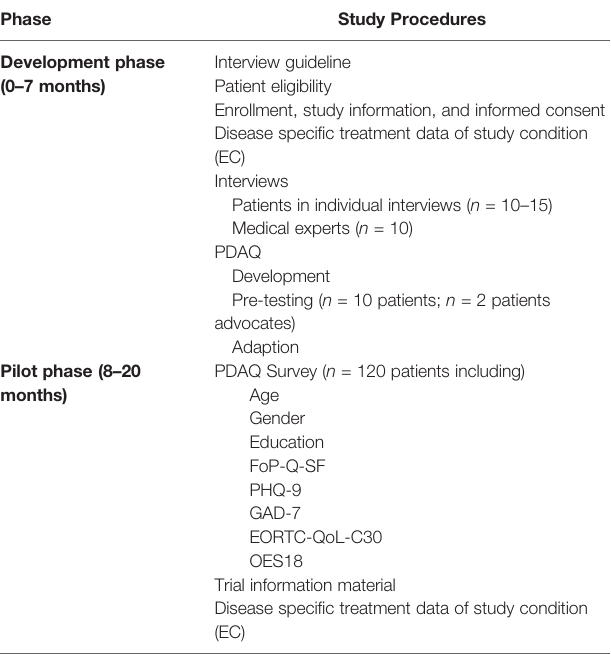
TABLE 1 | Study procedures.